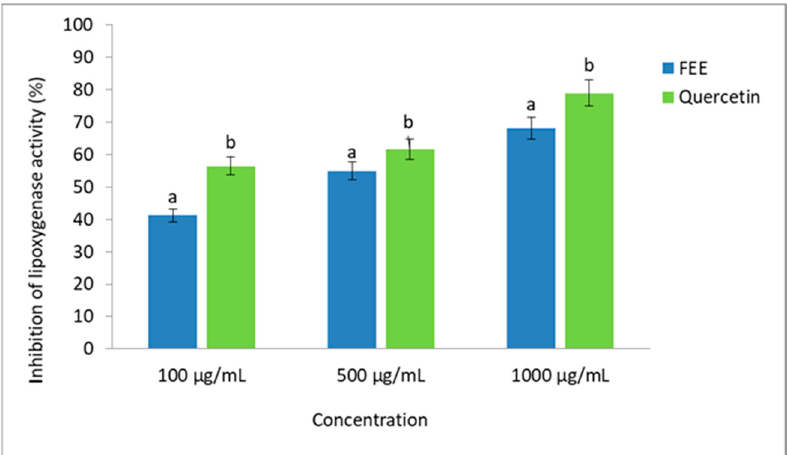
Figure 6. Influence of ethanolic extracts from E. angustifolium (FEE) on lipoxygenase inhibition. Quercetin was used as a control inhibitor. Data are the mean ± SD of three independent experiments, each of which consisted of two replicates per treatment group. Vertical lines represent the standard deviation. Different letters—values are significantly different, α < 0.05.